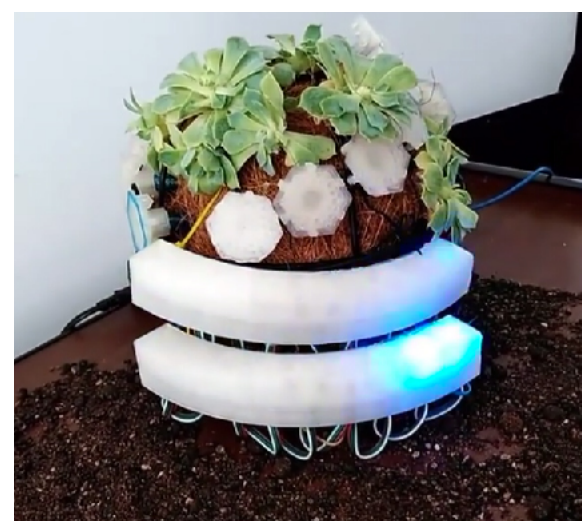
Figure 2. Prototype 2